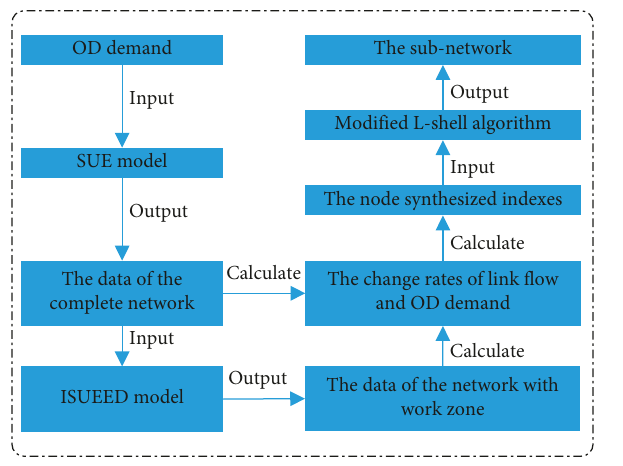
Figure 1: The framework of the